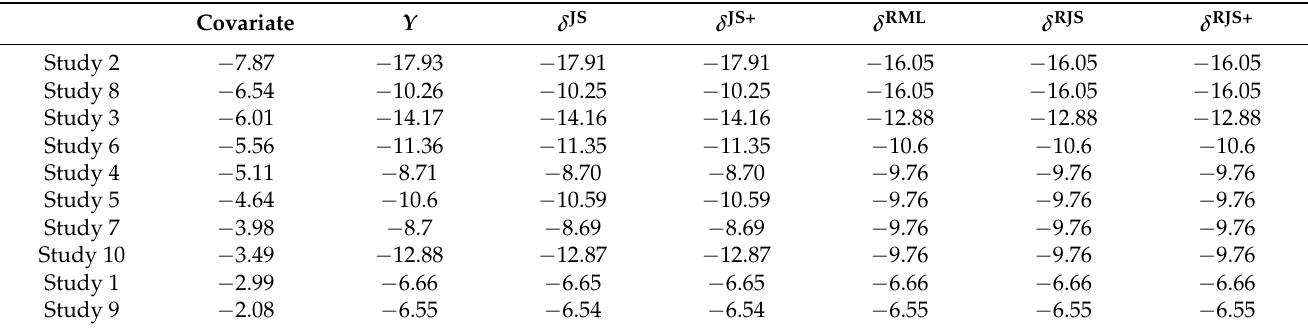
Table 2. The treatment effect estimates on the SBP based on the 10 studies from the blood pressure data. The 10 studies are ordered by the covariates (treatment effect estimates on the DBP). Covariate 𝒀 𝛅 𝑱𝑺 𝛅 𝑱𝑺(cid:2878) 𝛅 𝑹𝑴𝑳 𝛅 𝑹𝑱𝑺 𝛅 𝑹𝑱𝑺(cid:2878) Study 2 − 7.87